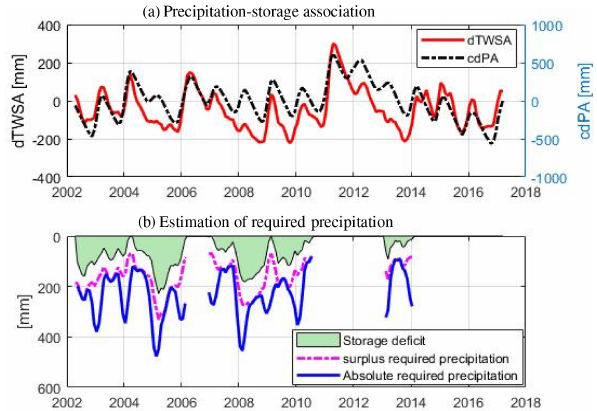
Figure 3. Estimation of the required precipitation at an example location. (a) Cumulative detrended precipitation anomaly (cdPA) compared with the detrended storage anomaly (dTWSA). (b) Sur- plus required precipitation is estimated (magenta plot), from the lin- ear relationship between dTWSA and cdPA, to fill the storage deficit (green plot). Then, precipitation climatology is added to obtain the absolute required precipitation (blue